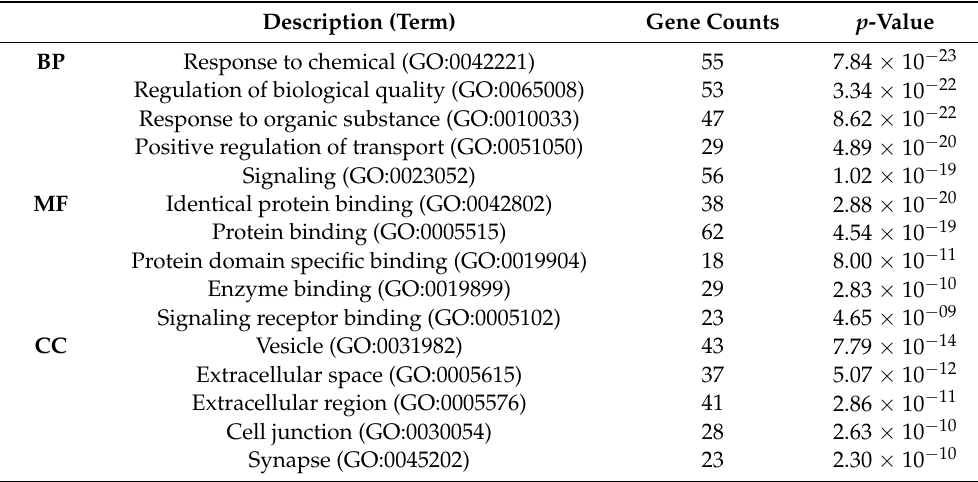
Table 1. The GO enrichment analysis of SOD1-ALS pathway molecules, highlighting top-enriched biological processes, molecular functions, and cellular